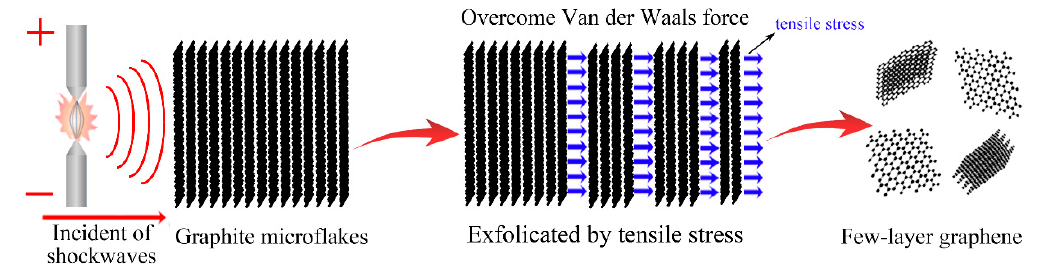
Figure 9. Schematic illustration of the formation of few-layer graphene using pulsed discharge in graphite micro-flake suspension.